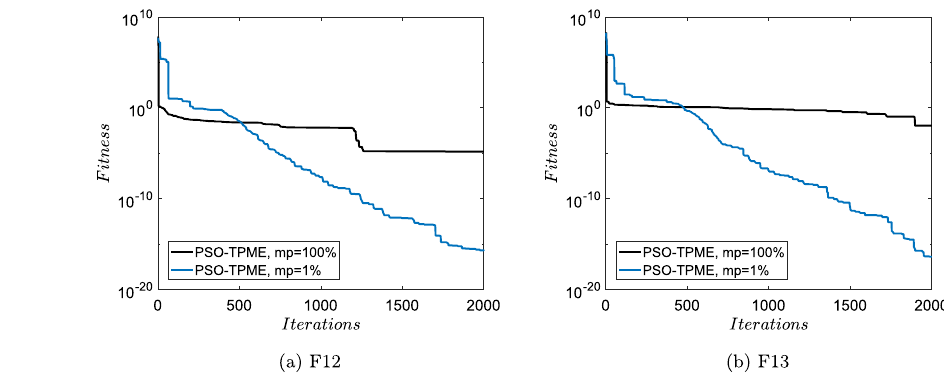
Fig. 6 Fitness performance of PSO-TPME on 30-dimensional functions F12 and F13 with dif- ferent mutation probability